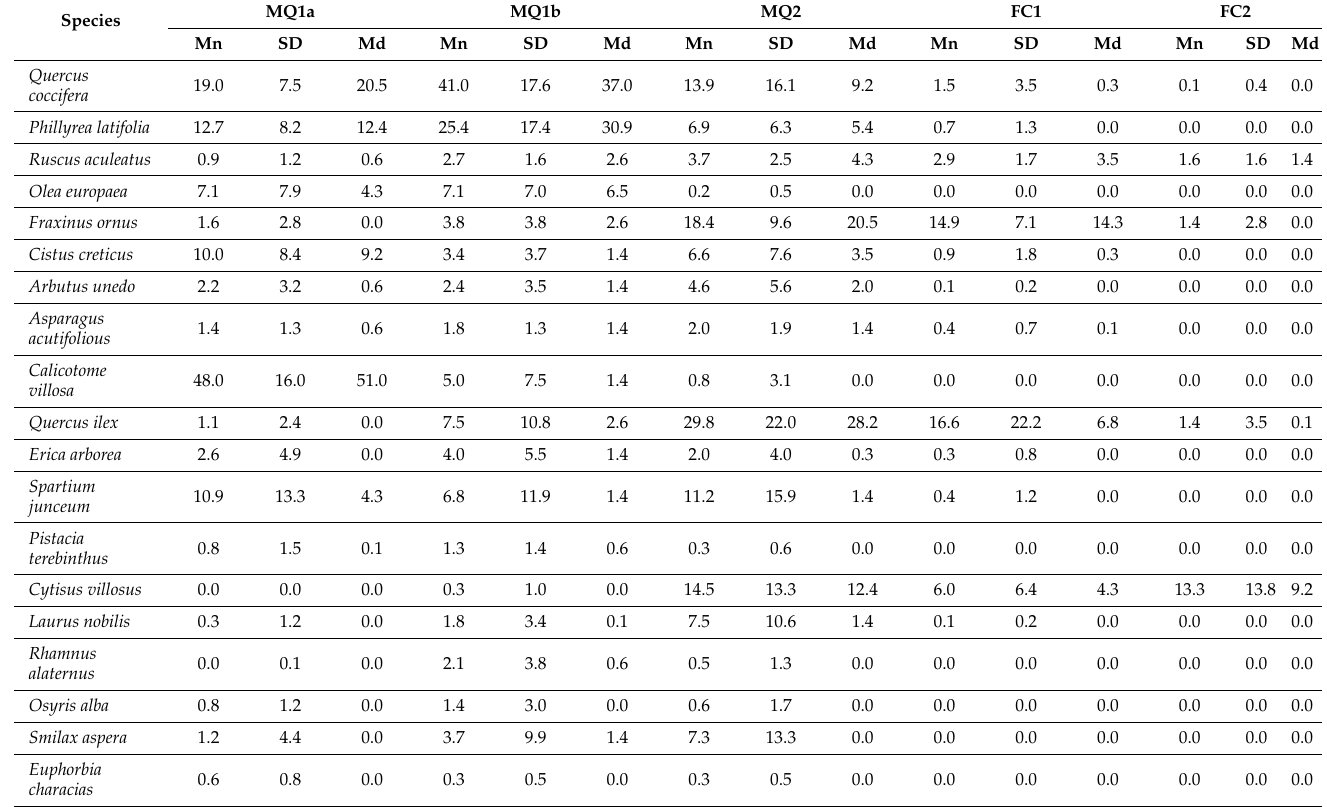
Table 4. Mean (Mn), Standard Deviation (SD) and Median (Md) cover for all constant and frequent species in each community and